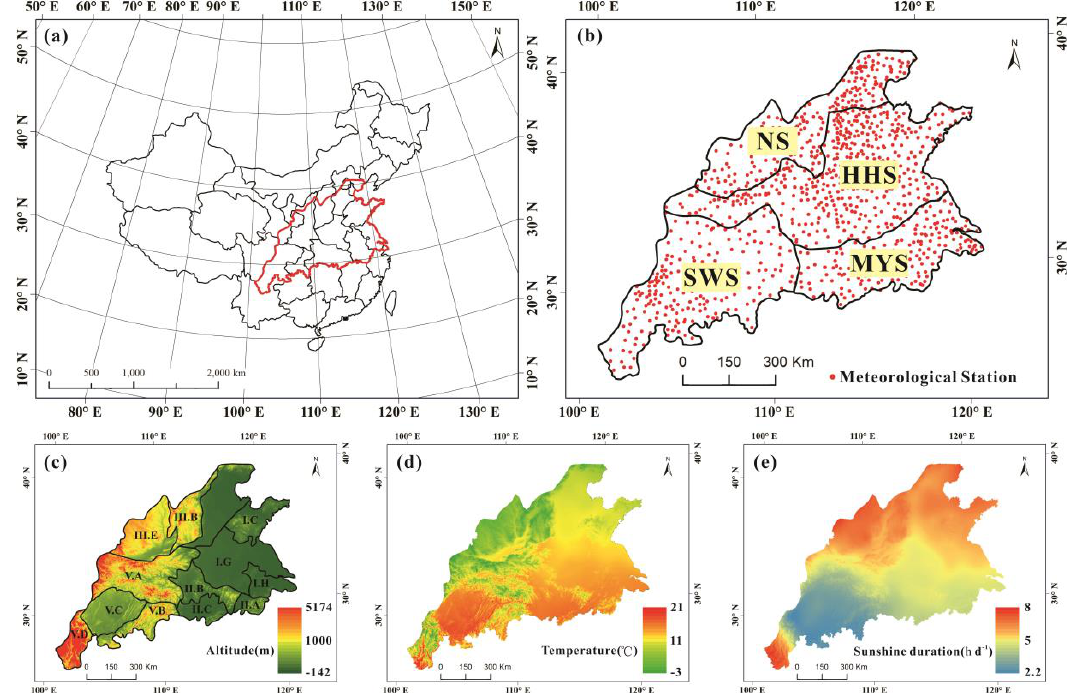
Figure 1. Overview of the research area: Geographic location and distribution of the sub-regions and the meteorological stations ( a , b ), digital elevation ( c ), 2000–2009 daily average temperatures ( d ), average hours of sunshine in 2000–2009 ( e ). SWS: Southwest winter wheat sub-region; NS: North winter wheat sub-region; HHS: Huang-Huai winter wheat sub-region; MYS: Middle-lower reaches